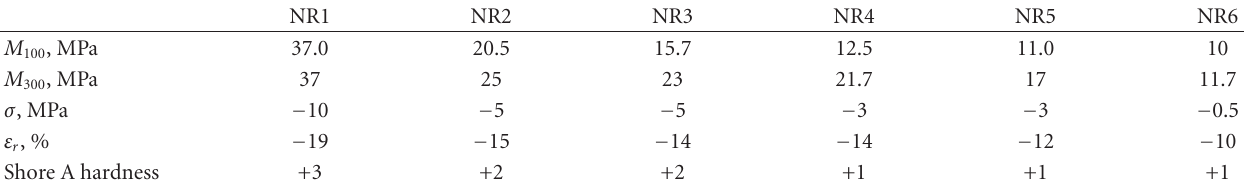
Table 4: Aging coe ffi cients of composites comprising